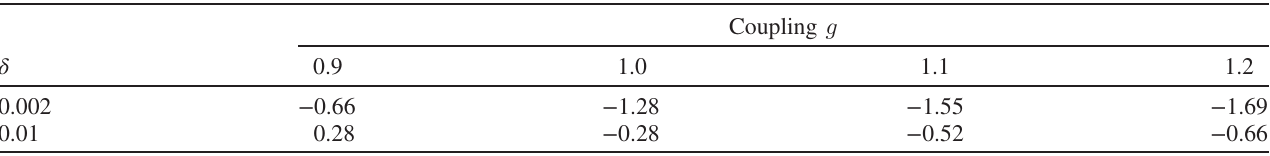
TABLE I. Examples of stable chaos. The largest Lyapunov exponent is listed for two different δ values and different coupling g ( N ¼ 64 000